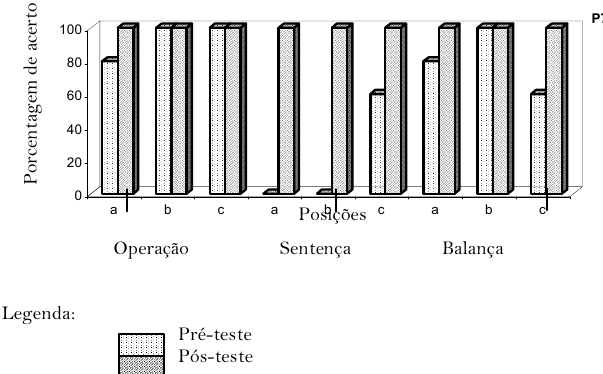
Figura 1. Porcentagens de acerto no pré-teste e pós-teste, considerando a posição da incógnita nos problemas em forma de operação, sentença e